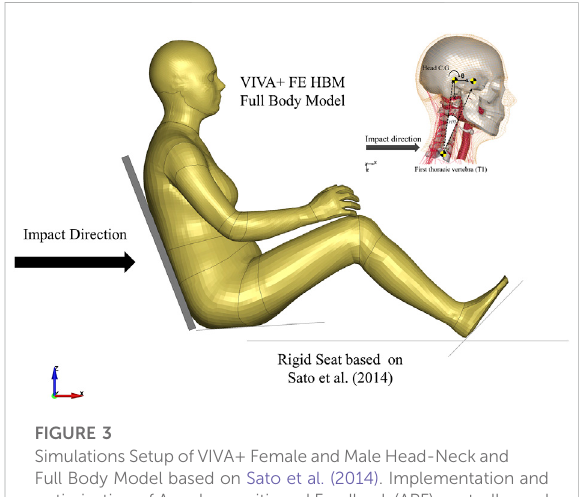
FIGURE 3 Simulations SetupofVIVA+ FemaleandMaleHead-Neckand Full Body Model based on Sato et al. (2014). Implementation and optimization of Angular-positioned Feedback (APF) controller and parallel damping element